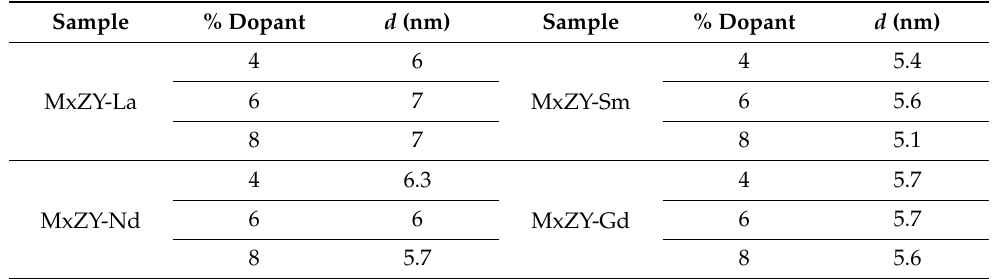
Table 2. Mean crystallite sizes of the initial hydrothermally synthesized ZrO 2 doped